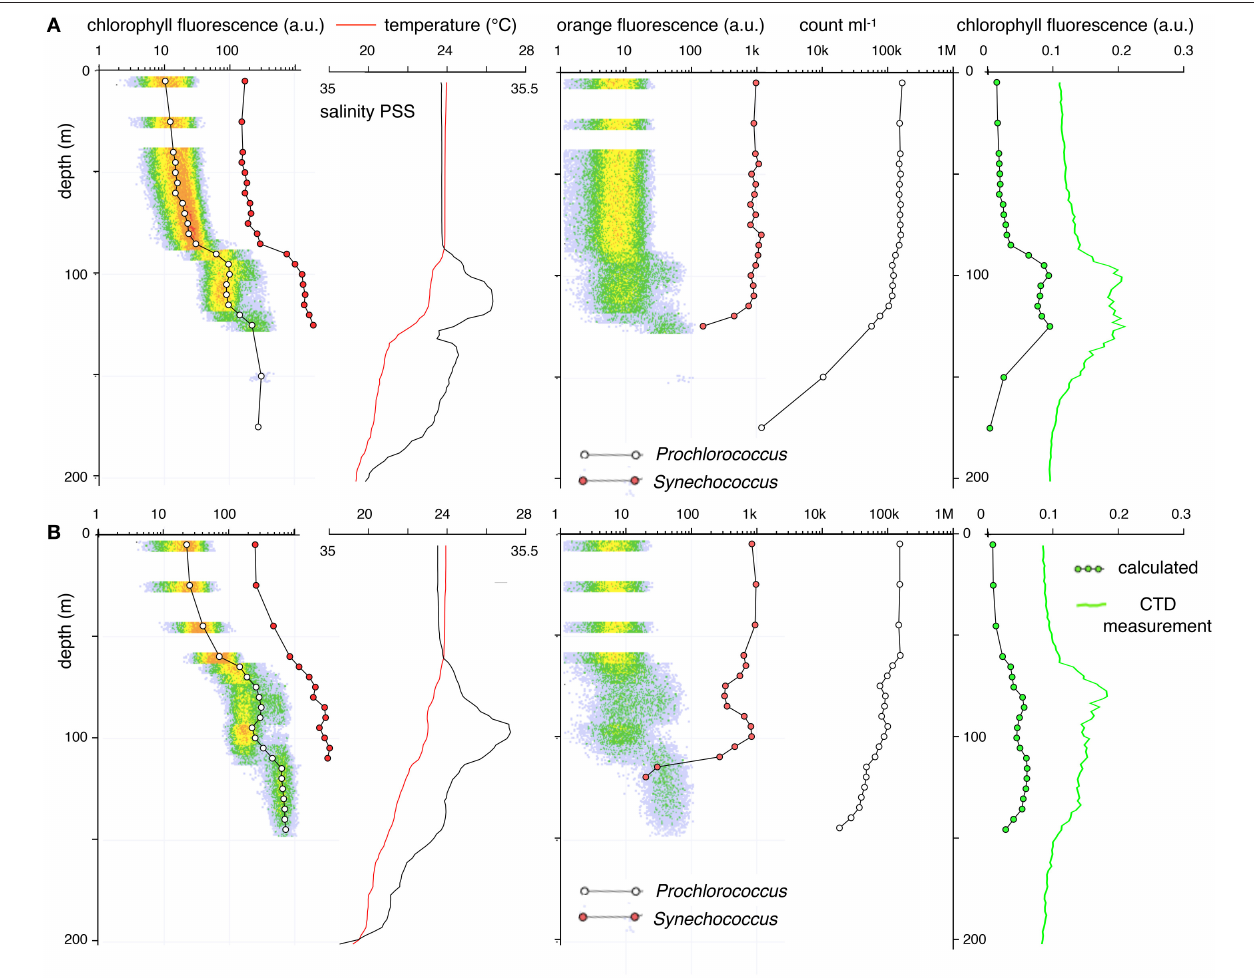
FIGURE 7 | Two examples of 5-m resolution flow cytometry profiles of Prochlorococcus and Synechococcus that show local inversion patterns that correlate with salinity/temperature anomalies. Symbol and line coloring as in Figure 6 . As the temperature of the high salinity layers equilibrates with that of the surrounding layers, the salt anomaly will descend and will be diluted by mixing with the lower salt layer underneath. The salinity/temperature anomalies correlate with discontinuities in the Prochlorococcus and Synechococcus fluorescence and abundance profiles. (A) March 19, 2014, 16:40 HST; (B) March 21, 2014, 17:00